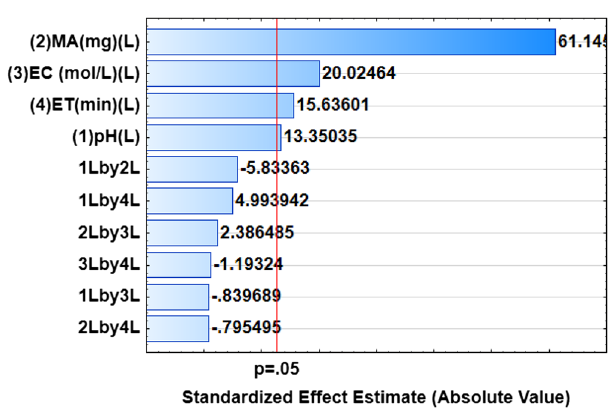
Figure 6. Pareto charts of standardized effects for optimization of preconcentration